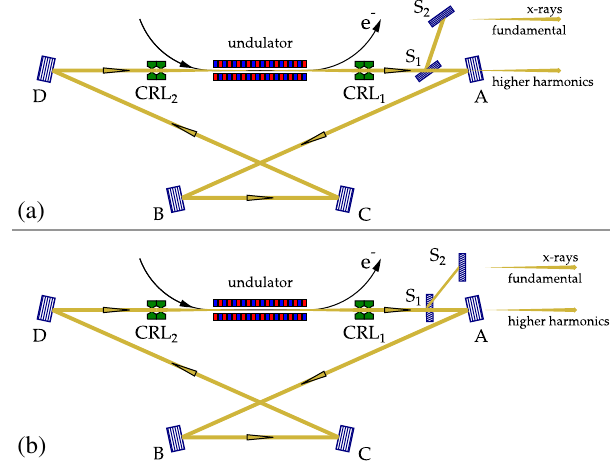
FIG. 3. “ Beam-splitter ” output coupling methods presented in the example of the four-crystal cavity. In contrast to the scheme of Fig. 1, all four Bragg-reflecting crystals (A, B, C, and D) are thick and are featuring highest reflectivity for the fundamental har- monic. The fundamental is now coupled out through a thin beam- splitter crystal S 1 , while higher harmonics can be coupled out through transparent-for-them crystal A. Beam-splitter crystal S 1 (output coupler) and crystal S 2 designed for fixed-exit out- coupling can be either in the reflection (Bragg-case) geometry (a) or in transmission (Laue-case) geometry (b). Other types of beam splitters can be used instead of the Bragg-reflecting crystals as